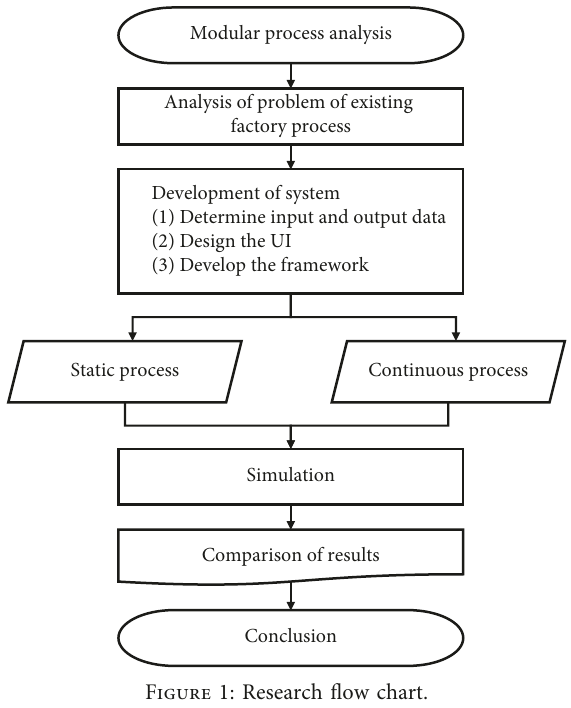
Figure 1: Research flow chart.